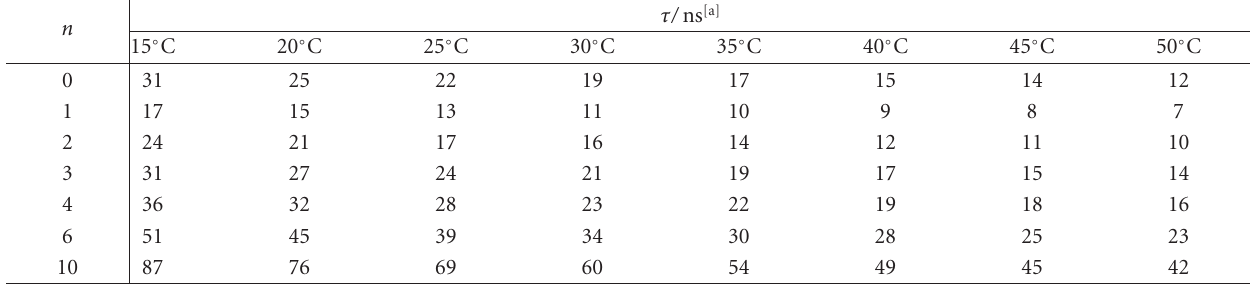
Table 1: Dependence of the fluorescence lifetime on the length of Trp-(Gly-Ser) n -Dbo-NH 2 probe/quencher-labeled peptides in D 2 O at di ff erent